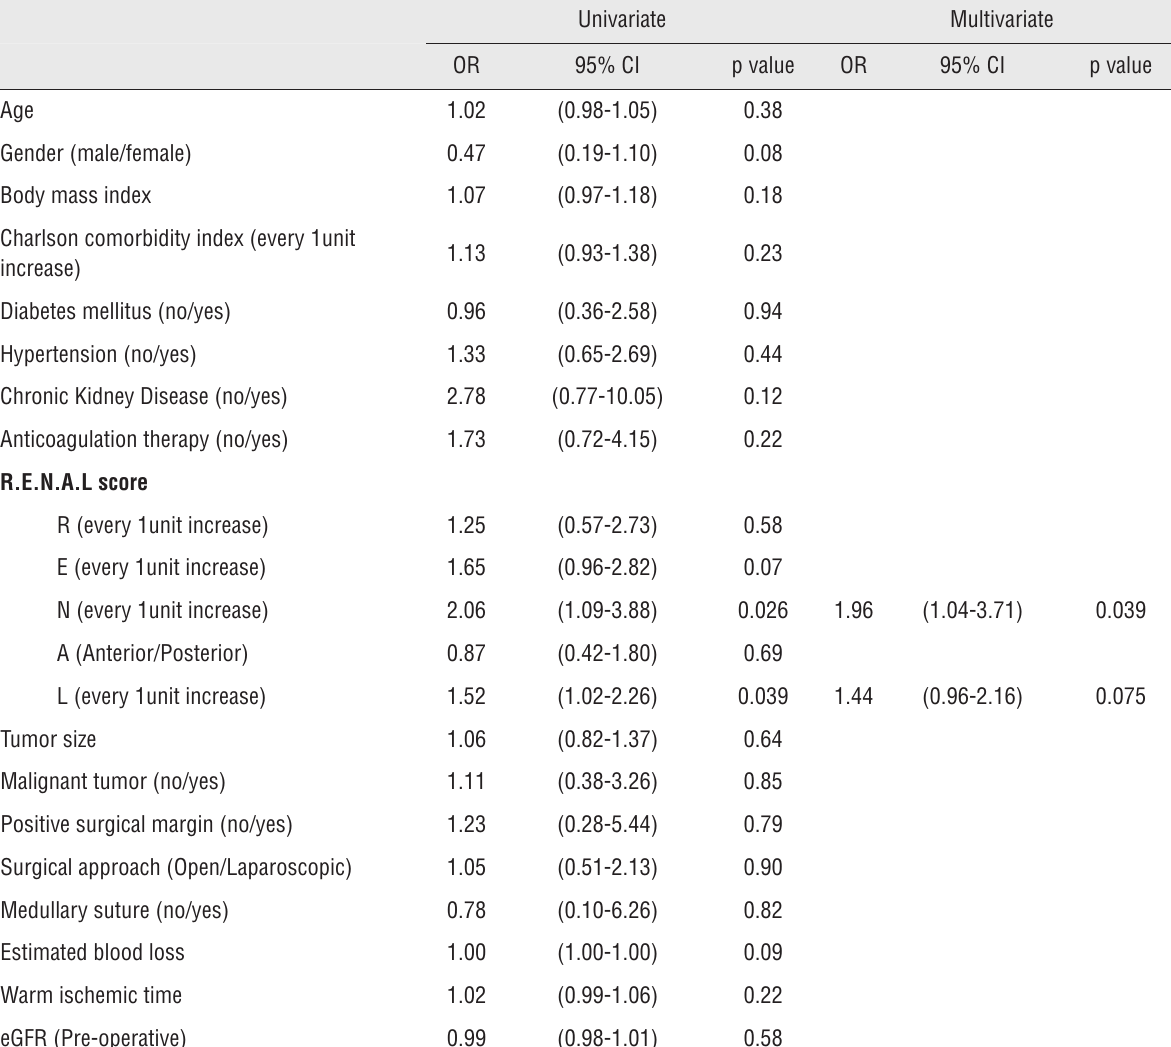
Table 2 - Univariate and multivariate logistic regression analysis of factors influencing the occurrence of RAP or AVF after partial